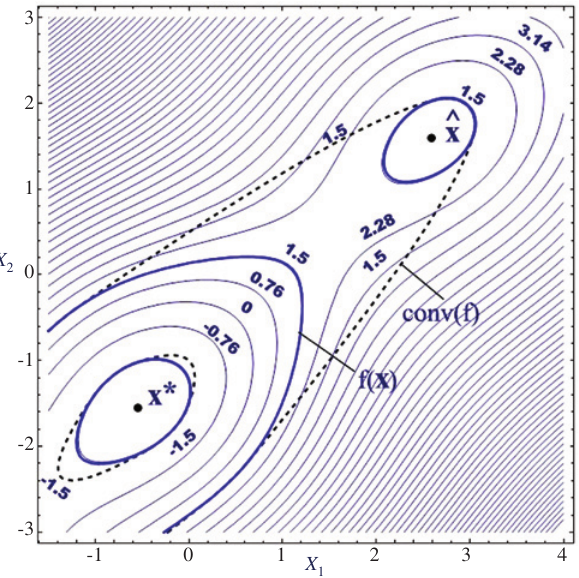
Figure 4: Contours of the underestimating function with solutions in Example 4.